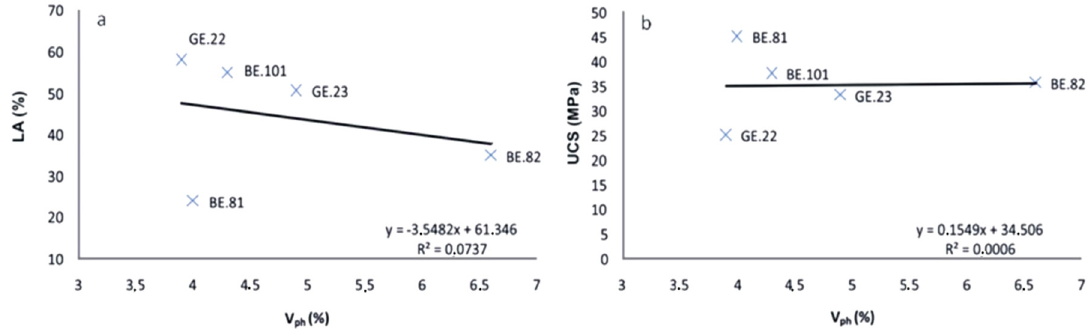
Figure 9. ( a ) The Los Angeles abrasion test ( LA (%)) versus the petrographic index ( V ph (%)) of the studied volcanic rocks; ( b ) the uniaxial compressive strength test ( UCS (MPa)) versus the petrographic index ( V ph (%)) of the studied volcanic rocks.